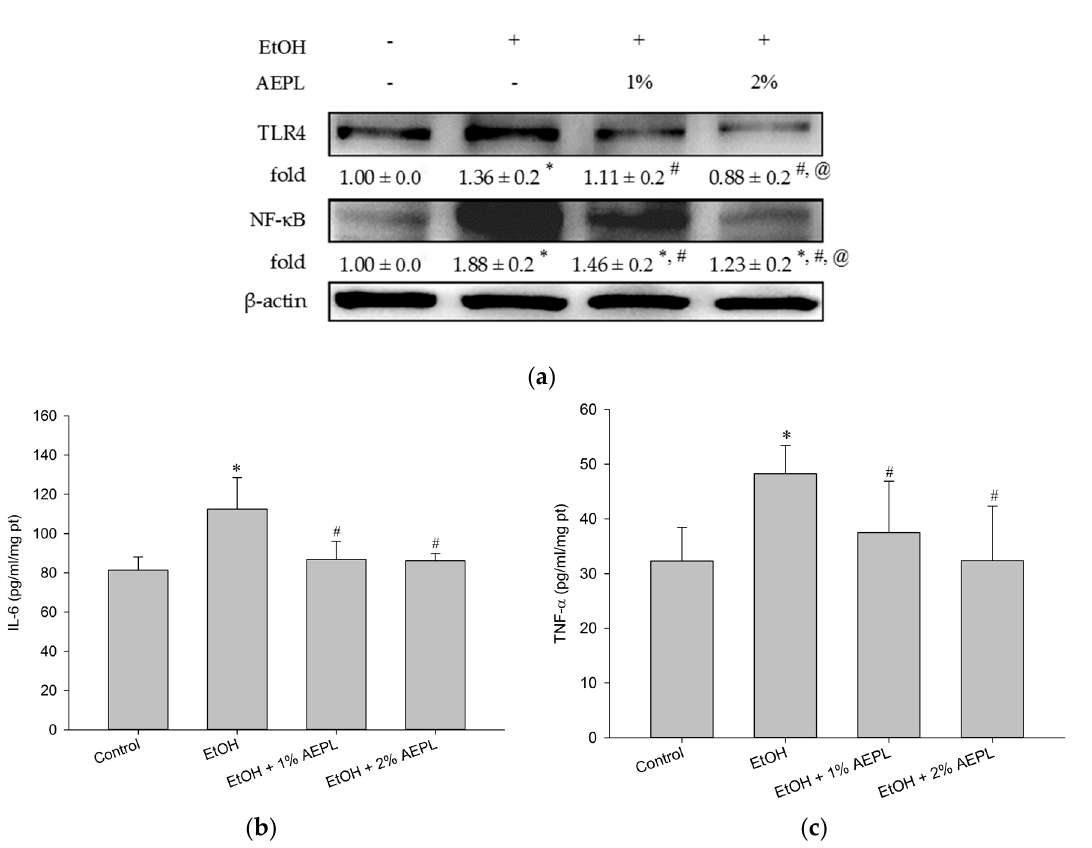
Figure 4. Effect of alcohol and 1% or 2% AEPL on the protein levels of TLR 4, NF- κ B, IL-6 and TNF- α . ( a ) The protein level of TLR 4 and NF- κ B. ( b ) The level of IL-6 in liver. ( c ) The level of TNF- α in liver. +/– indicates whether the diet contains with/without ethanol or AEPL. Data were presented as mean ± SD from at least 3 independent experiments, and expressed as the percentage of the control. * p < 0.05, compared with control group; # p < 0.05, compared with ethanol group; @ p < 0.05, compared with EtOH + 1% AEPL group. Table 4. Effects of different dose of AEPL on the antioxidant substances and TBARS in alcohol-induced liver injury in